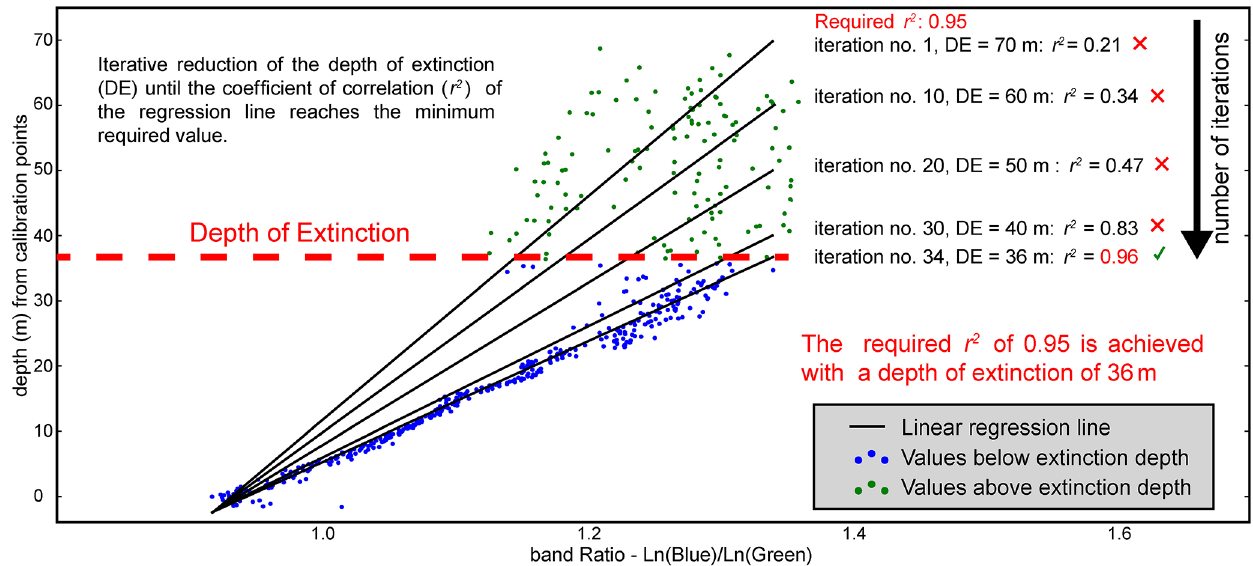
Figure 7. Illustration of the iterative process used to determine the depth of extinction of each satellite image and the resulting regression line. The gain and the offset of this line correspond to the parameters m 0 and m 1 . For data sources, see Sect.